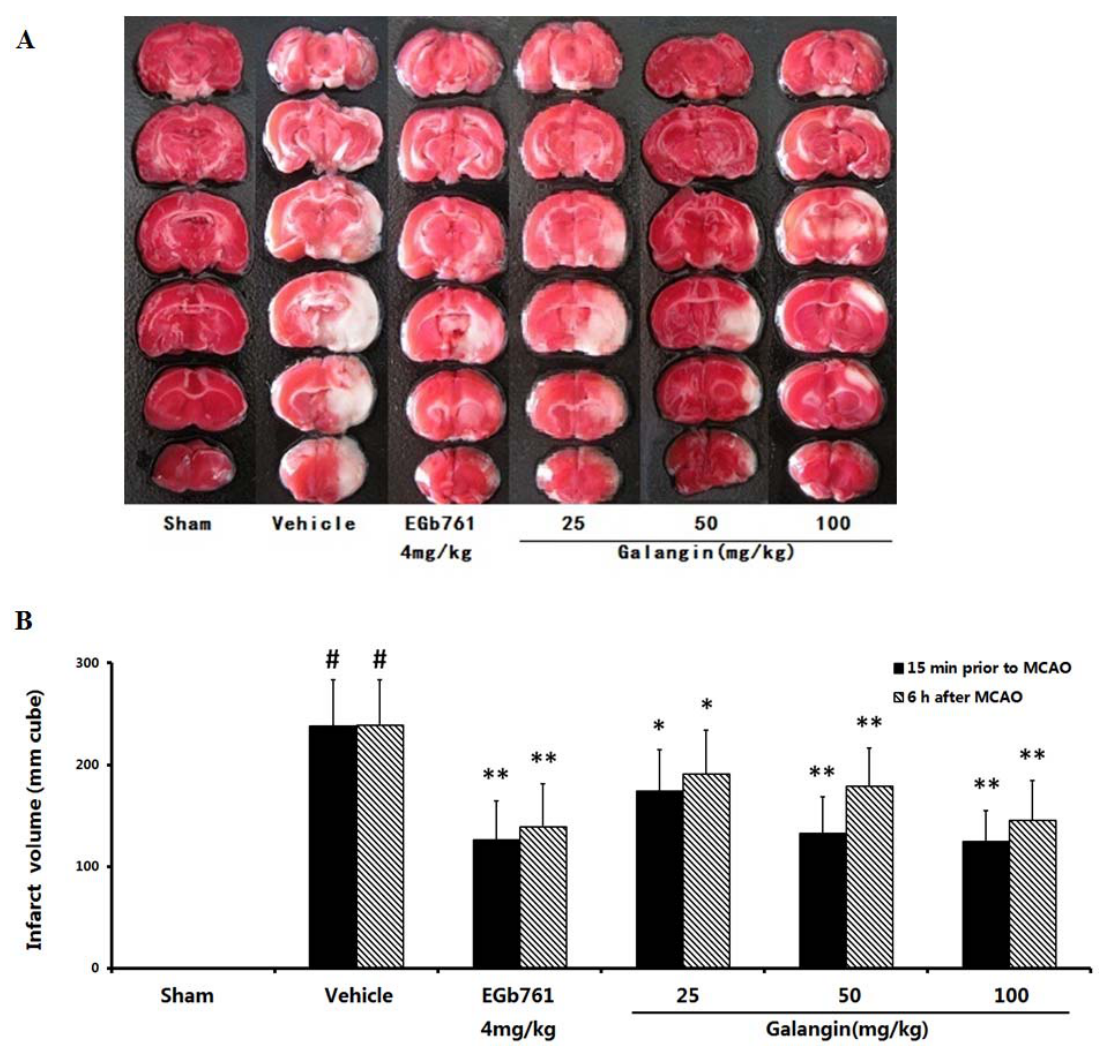
Figure 2. Effects of galangin on the infarct volume of rats induced by MCAO. ( A ) Illustrative coronal sections showing the infarct volumes in the cerebral hemisphere as adistinct, pale stained area in the rats subjected to ischemia and the attenuation of the infarct volume by treatment with galangin; ( B ) The effects of galangin on the infarct volume of rats induced by MCAO. EGb761 and galangin were both administered by i.g. 15 min prior to MCAO and 6 h after MCAO. The values were expressed as the mean ± SD (n = 10), and the data were analyzed by one-way ANOVA. ## p < 0.01, # p < 0.05 versus the sham group; ** p < 0.01, * p < 0.05 versus the vehicle